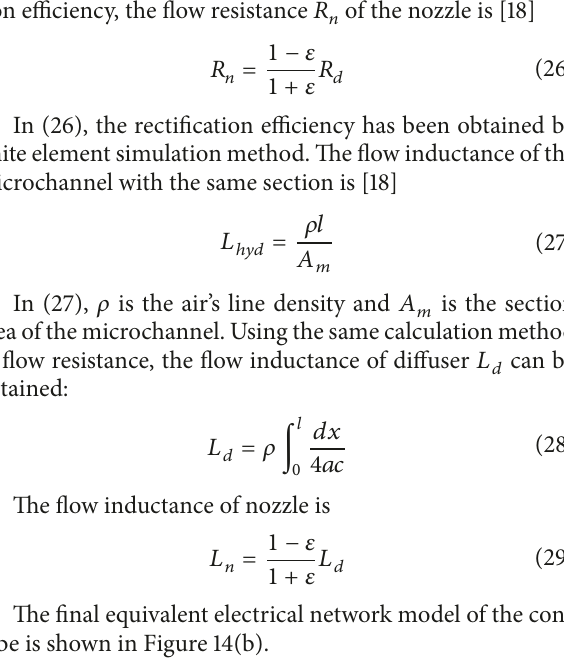
Table 2: Suction cavity’s geometric